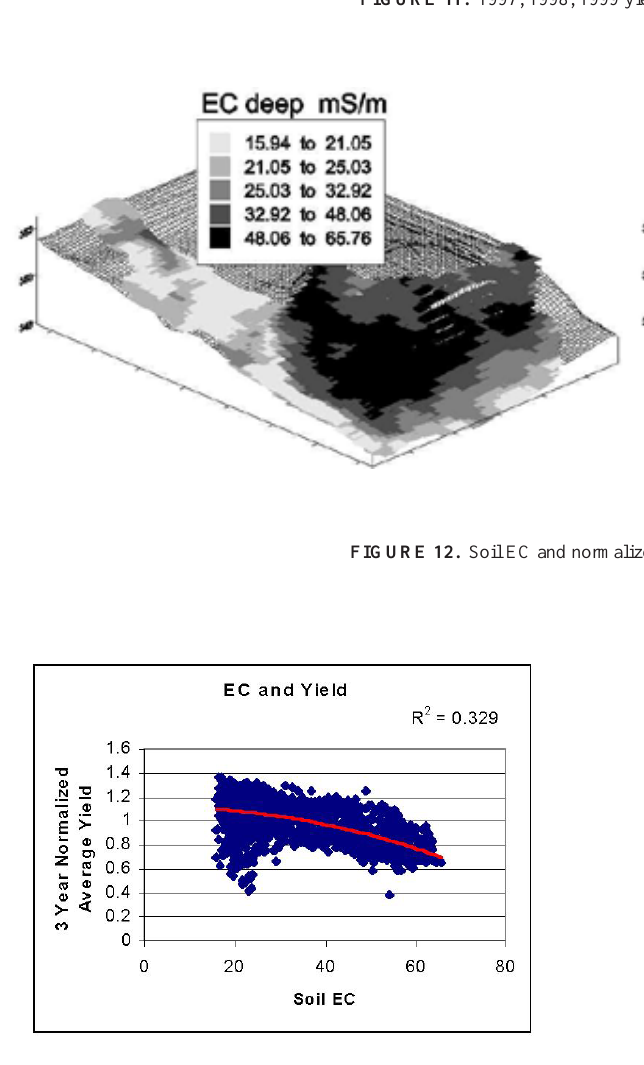
FIGURE 13. Scatter plot of EC and 3-year normalized average yield data. FIGURE 14. Boundary line plot of EC and 3-year normalized yield